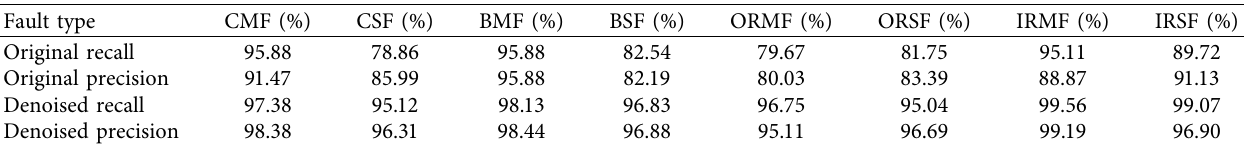
Figure 18: Confusion matrices of faults classifcation. (a) Denoised confusion matrix. (b) Original confusion matrix. Table 4: Model calculation efciency.